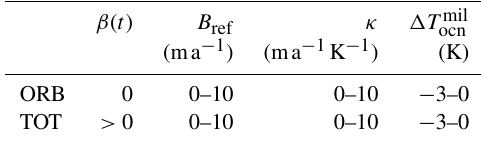
Table 1. Range of parameter values sampled by the LHS technique for generating the TOT and ORB